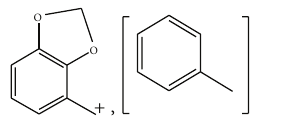
Figure 3: Fragment of urushiol methylene acetal under